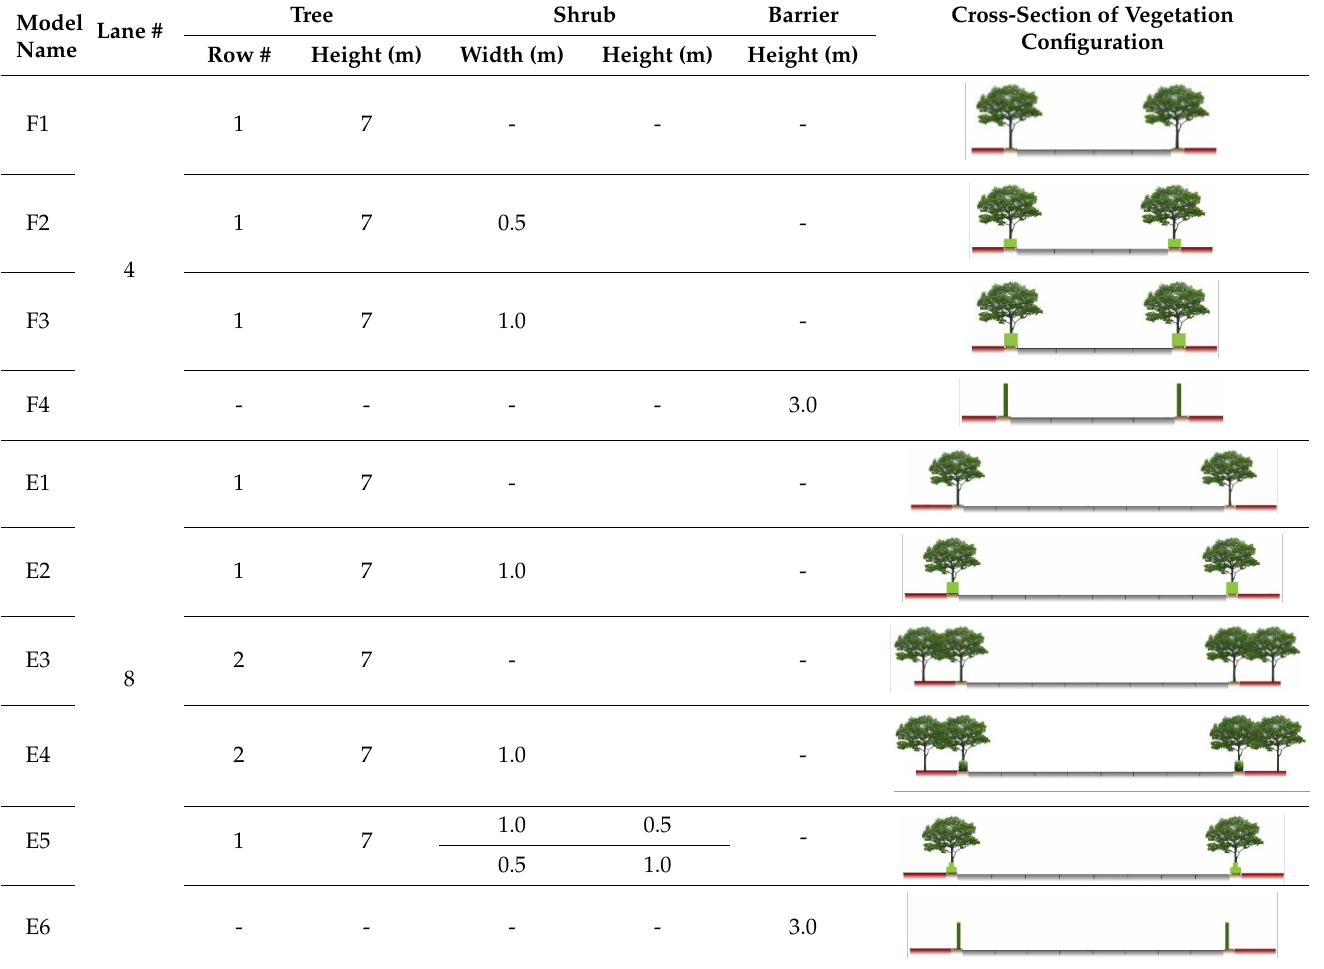
Table 1. Modeled vegetation configurations categorized by roadway